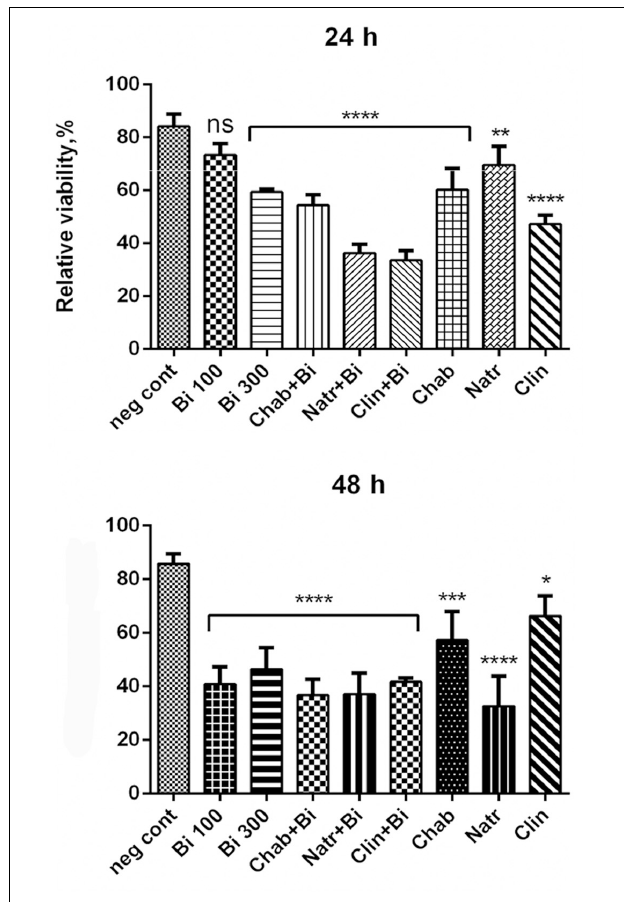
FIGURE 2 | Cytotoxicity of binase-loaded zeolites (300 µ g/ml), pure zeolites (300 µ g/ml) and pure binase at two concentrations, 100 and 300 µ g/ml, toward human colon adenocarcinoma Caco2 cells. Data represent mean ± SEM of three independent experiments; ∗ P < 0.05, ∗∗ P < 0.03, ∗∗∗ P < 0.014, and ∗∗∗∗ P < 0.01, correspondingly vs. negative control obtained by adding water volume equal to volume of zeolite suspension and binase solution; ns, non-significant. Cell viability without any additives was taken as